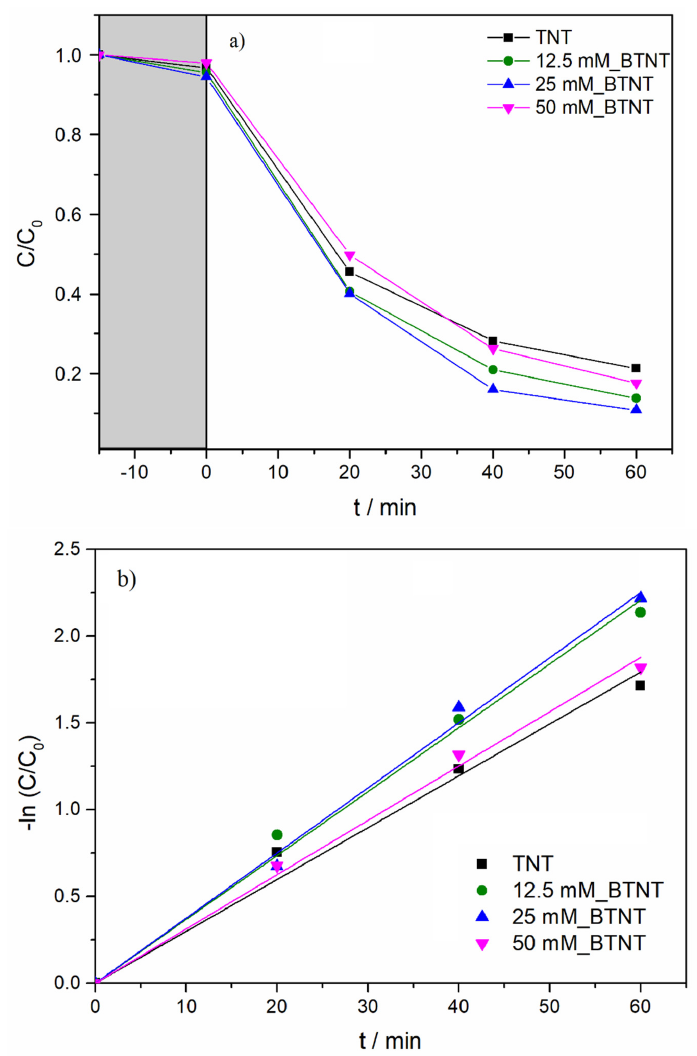
Figure 5. ( a ) Adsorption in the dark (interval from − 15 to 0 min; grey area) and photocatalytic degradation of DIC under UV/Vis for Ba-modified TNT photocatalysts with different Ba(OH) 2 concentrations. ( b ) Photocatalytic activities of TNT and Ba-modified TNT for photodegradation of DIC aqueous solution under ambient conditions. In comparison to TNT, the degradation efficiencies of the 12.5 mM_BTNT and 25 mM_BTNT photocatalysts were 23% and 28% higher than the reference TNT sample, re- spectively. This demonstrates that it is crucial to find an optimal concentration of Ba(OH) 2 precursor (in our case 25 mM). The 25 mM_BTNT sample was the most efficient in DIC